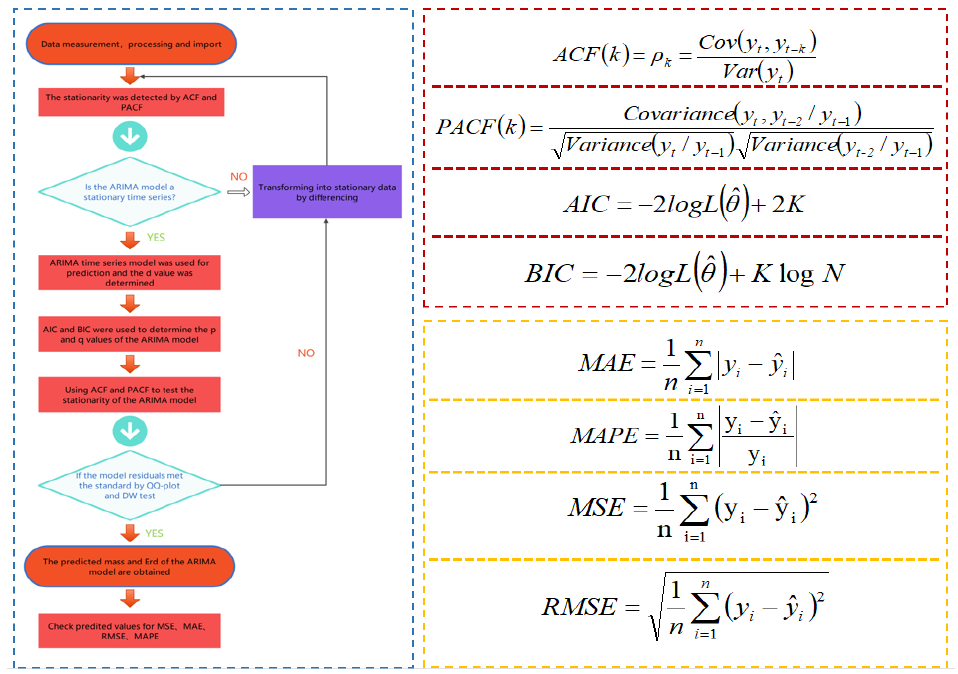
Figure 2. Algorithm showing the methodology for developing ARIMA models. Test of Model Data: ACF and